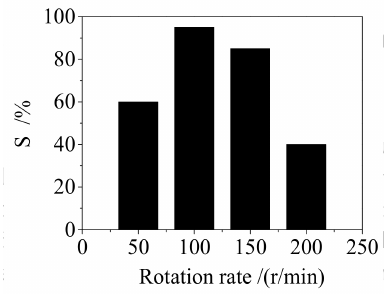
Figure 12. The e ff ect of the rotation rate on the survival rate of the